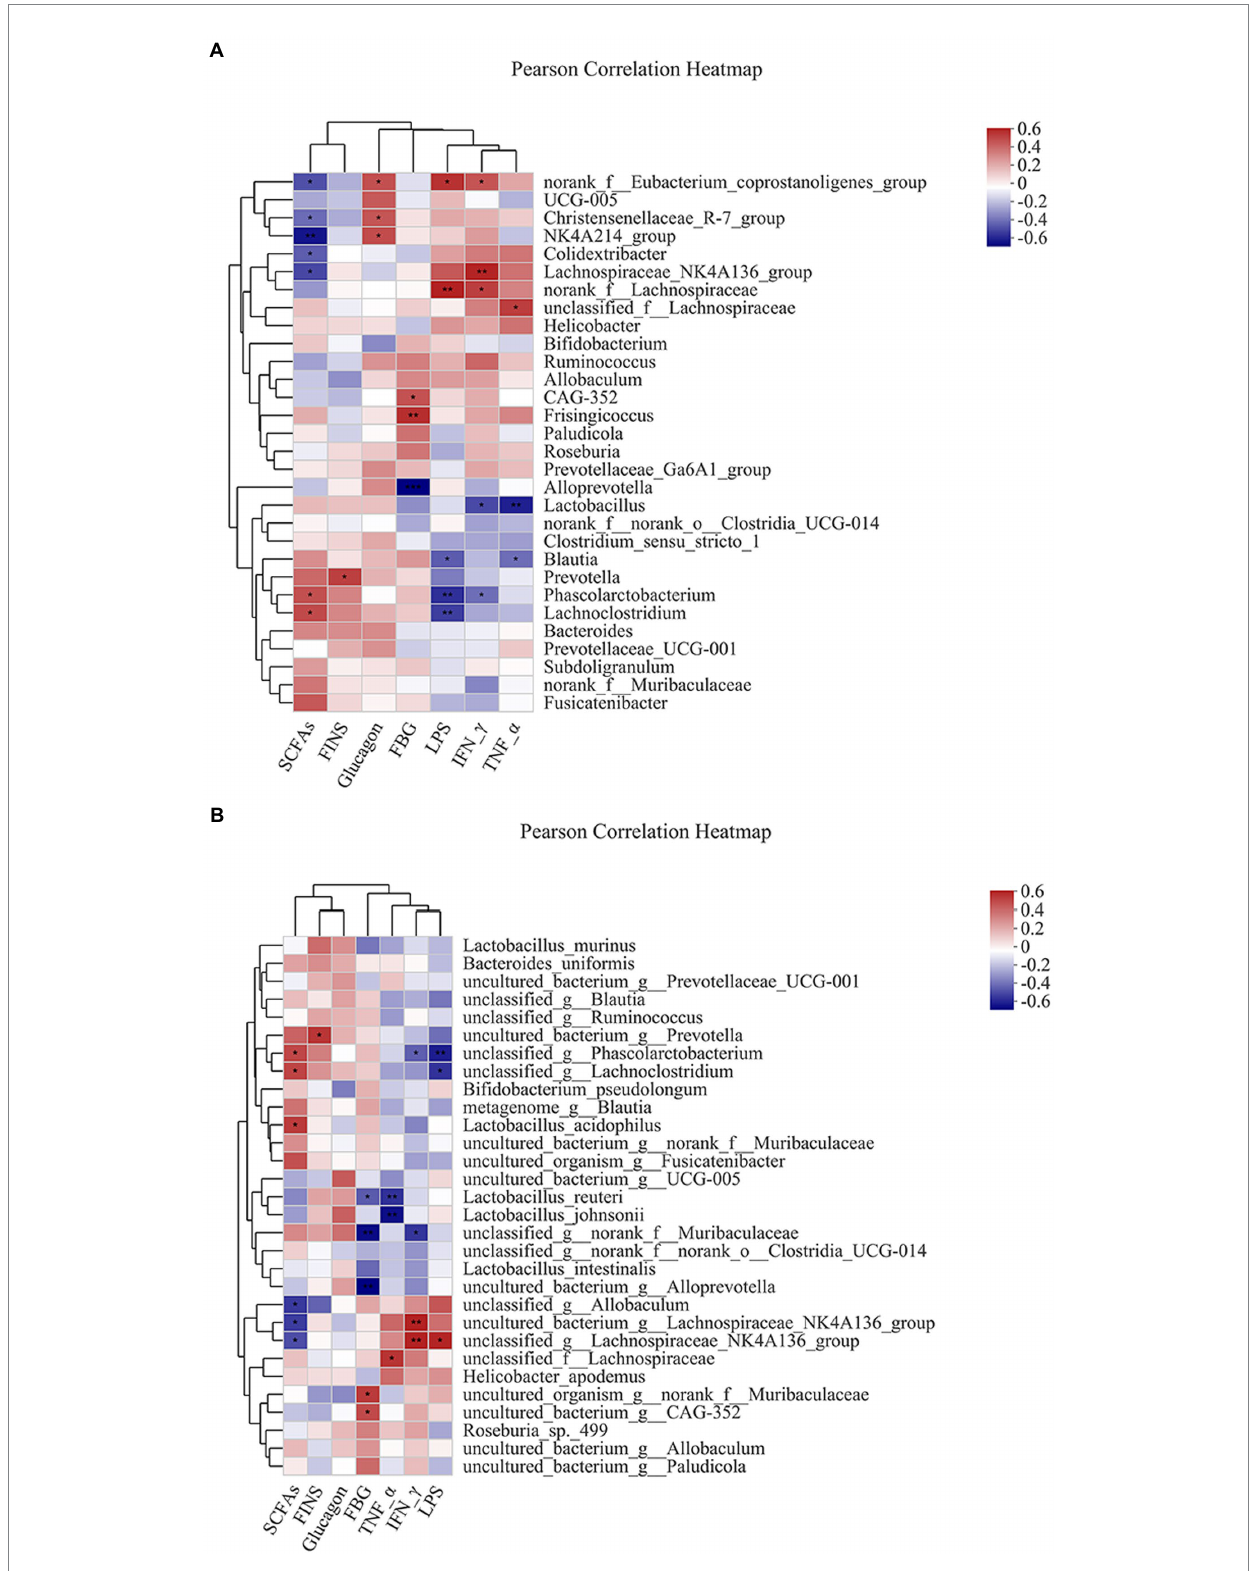
FIGURE 6 Heatmap of correlation analysis between intestinal bacteria and biochemical parameters. (A,B) represented the correlation analysis between intestinal bacteria and biochemical parameters at the genus and species levels. * p ≤ 0.05, ** p ≤ 0.01, *** p ≤